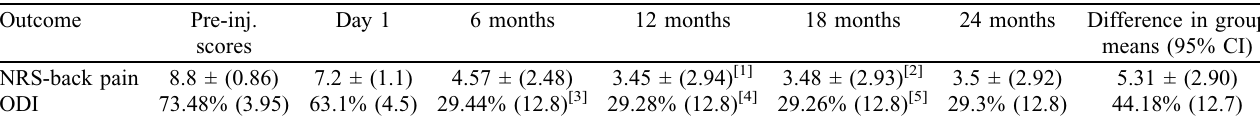
Table 1. Mean pre-injection and post-injection NRS (back) and ODI for lumbar multifidus muscle PLRP injection through the follow-up period.